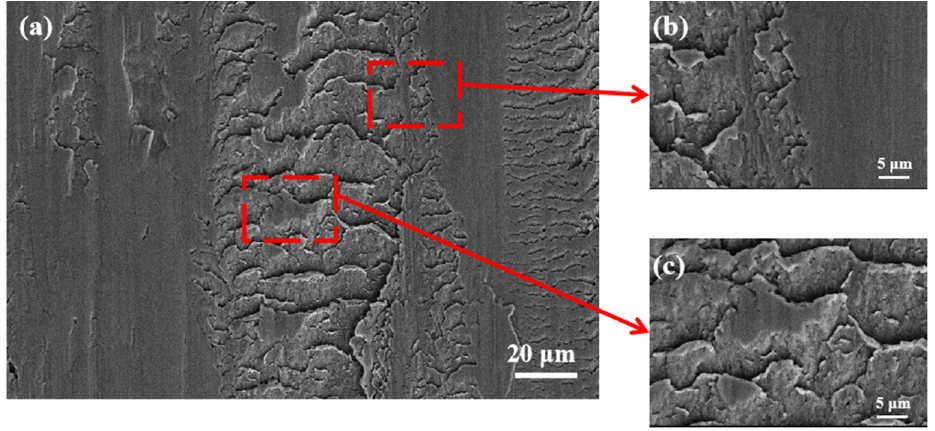
Figure 8. The worn marks on the surface of shim: ( a ) wrinkled worn marks, ( b ) amplification of the edge of the worn marks, ( c ) amplification of the worn marks.